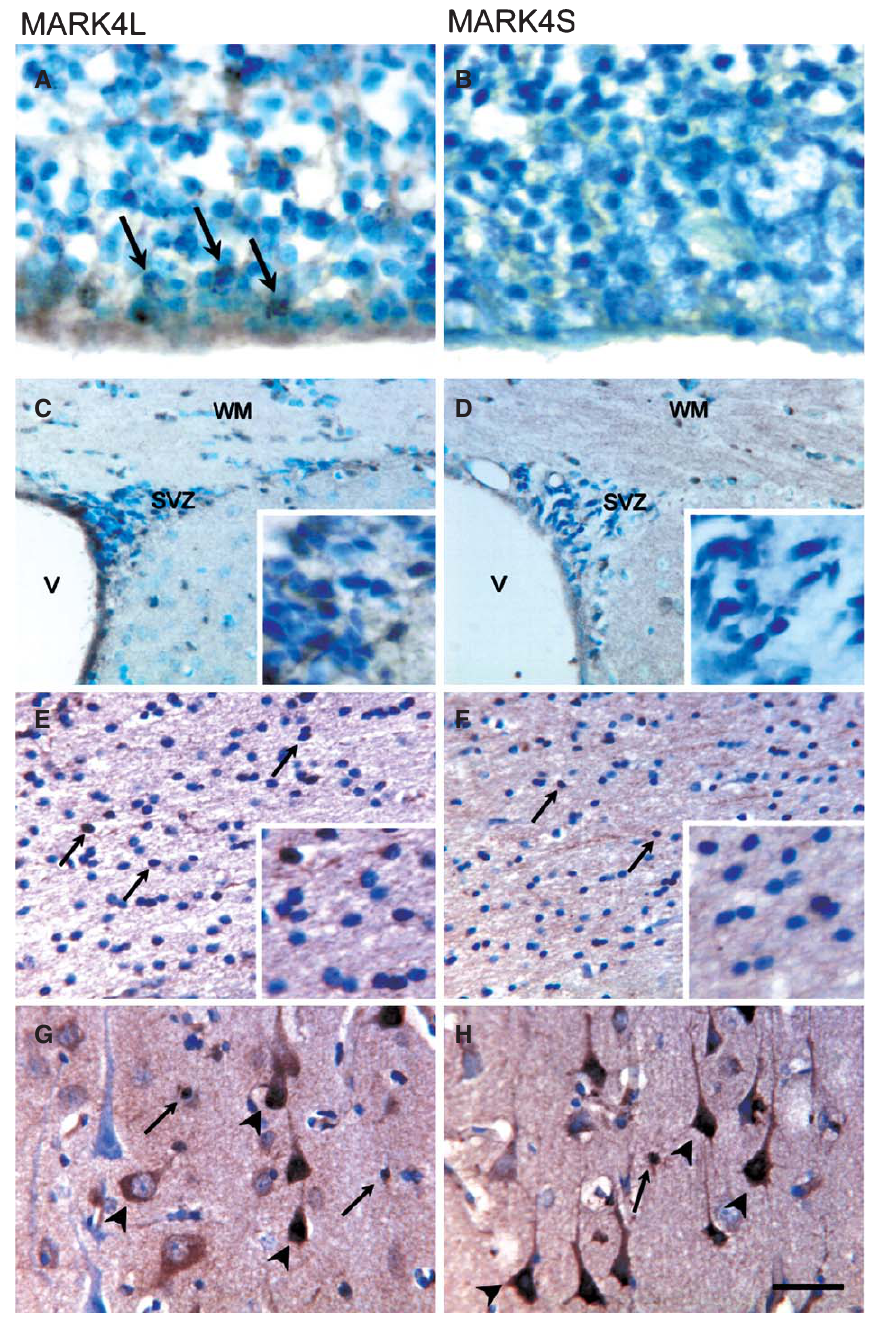
Fig. 5. In vivo expression of MARK4L and MARK4S in human and mouse brain. (A) MARK4L expression in some cells of the ventricular zone in the human embryo (arrows) and (B) lack of MARK4S expression in the same area. (C and high-magnification inset) MARK4L expression in some cells of the SVZ in the adult mouse brain and (D and high-magnification inset) lack of MARK4S expression in the same area. (E and G) MARK4L and (F and H) MARK4S are expressed in some glial cells (arrows) in the white matter of the adult human cerebral cortex. Both proteins are also expressed in several neurons (arrowheads in G and H) and in some glial cells (arrows in G and H) in the gray matter. V, ventricle; SVZ, sub-ventricular zone; WM, white matter. Scale bar=14.5 (cid:1) m in A, B and in insets in C, D; 74 (cid:1) m in C–H; 44.4 (cid:1) m in insets in E,